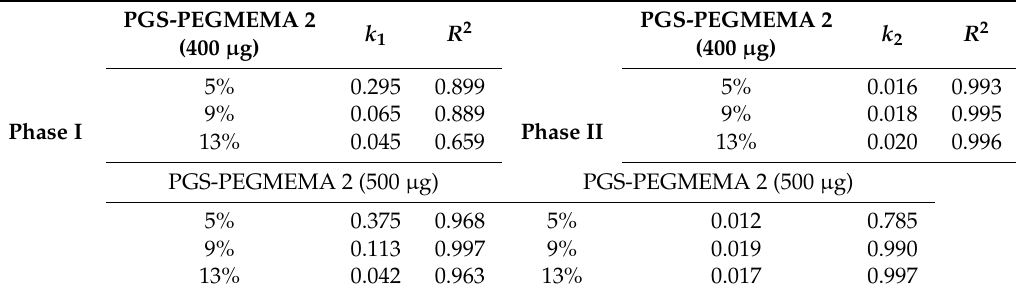
Table 4. The fit parameters, k 1 and k 2 , representing the release constants of Phase I and Phase II respectively for PGS-PEGMEMA 2 at payloads of 400 and 500 μ g. k 1 decreased with increasing α CD concentrations, and the values of k 1 were also higher for a payload of 500 μ g compared to that of 400 μ g at any particular α CD concentration. k 2 was relatively constant regardless of payload and α CD concentrations.